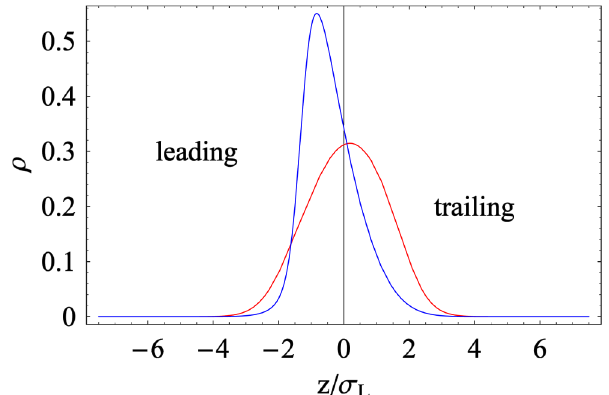
COHERENT BEAM STABILITY IN THE LOW MOMENTUM . .